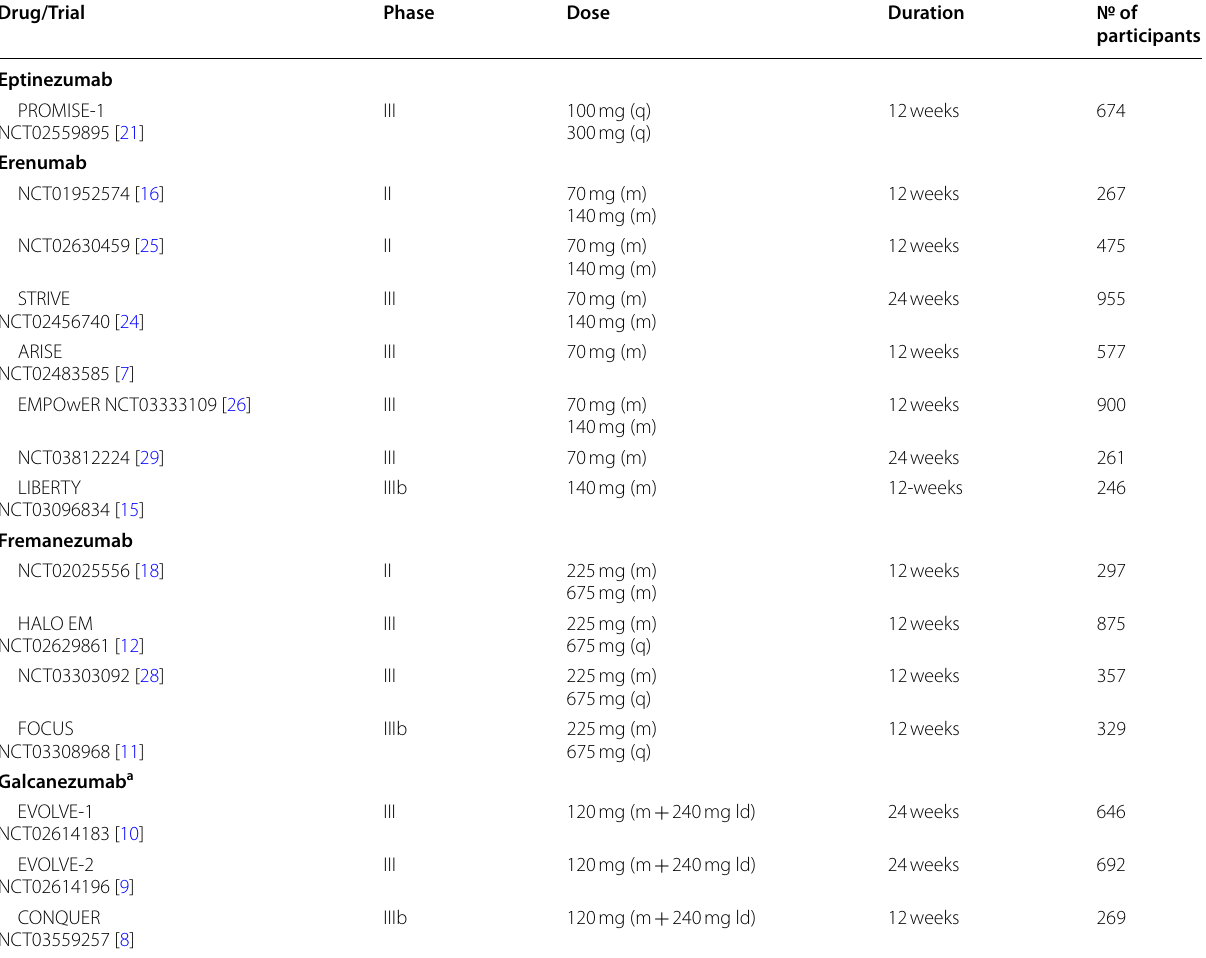
Table 3 Randomized placebo‑controlled phase II and III clinical trials in individuals with episodic